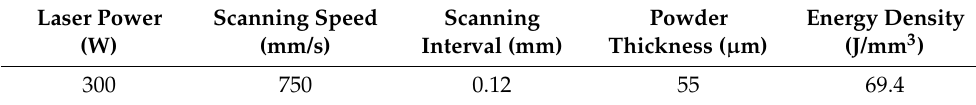
Table 4. MS1 laser additive process parameters and metal laser additive process parameters.